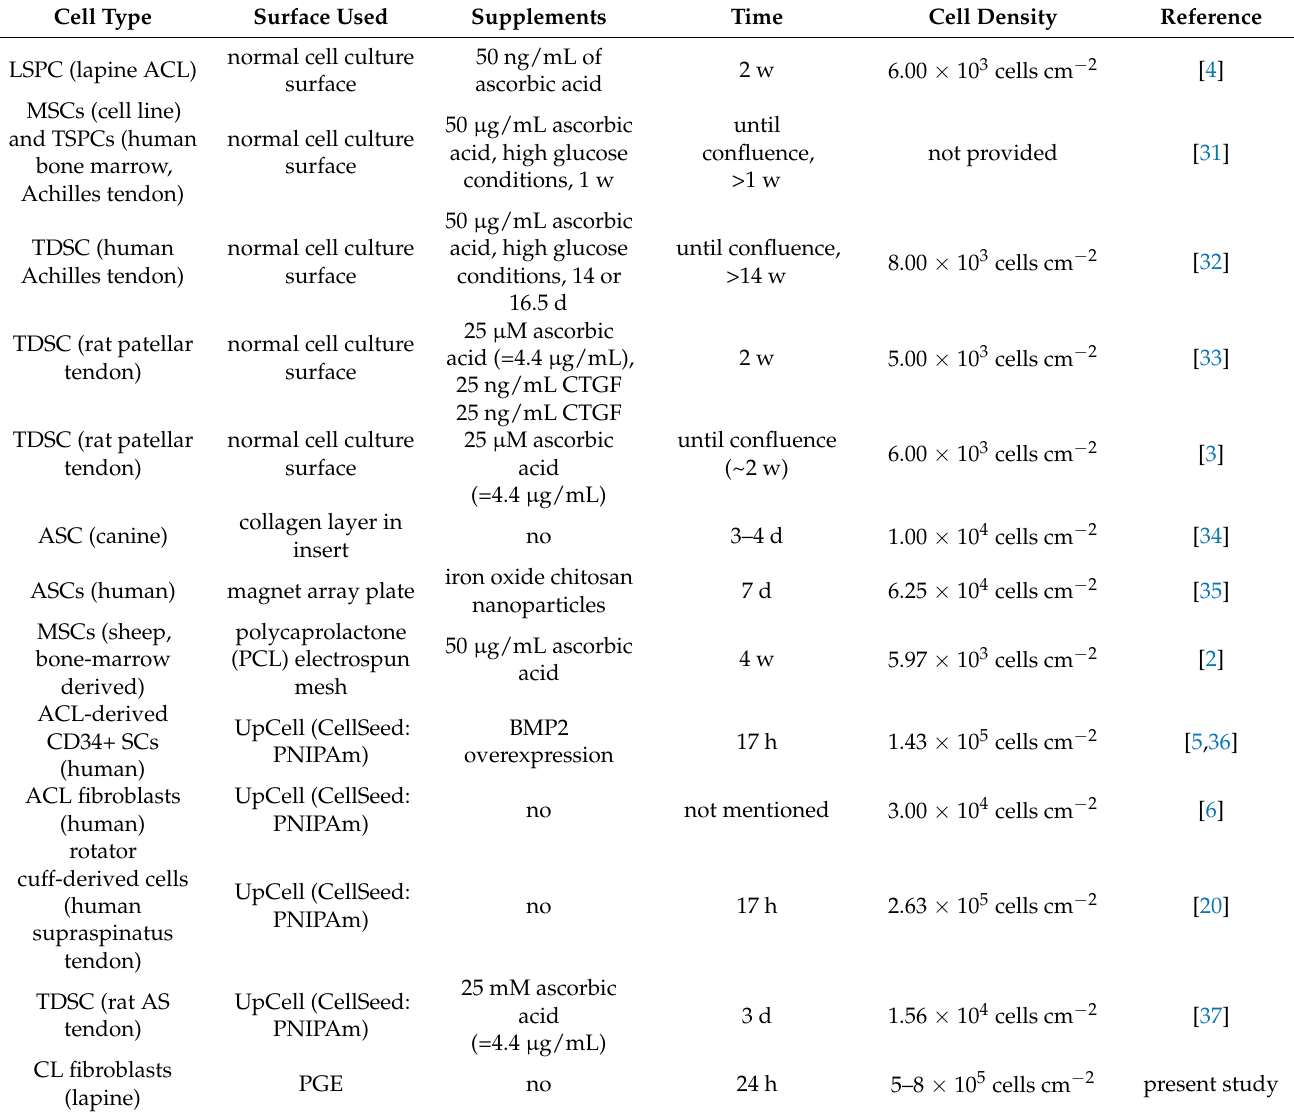
Table 1. Sheet preparation techniques used for tendon and ligament tissue